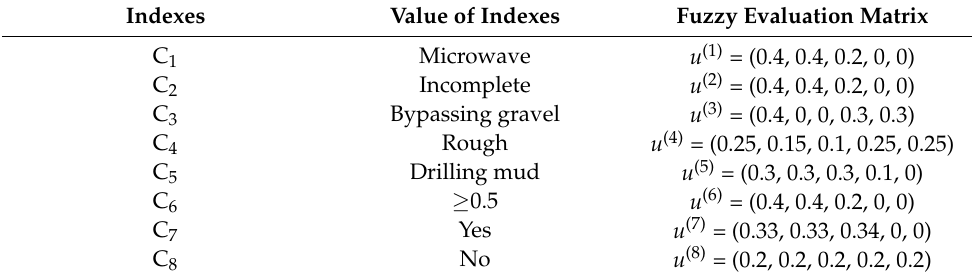
Table 5. Fuzzy evaluation of a single